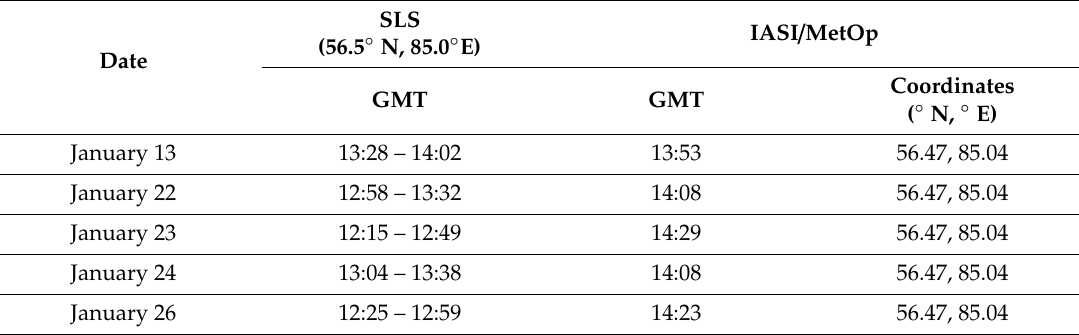
Table 3. Coordinates and time of IASI / MetOp and lidar sounding used for the comparison of OVD in